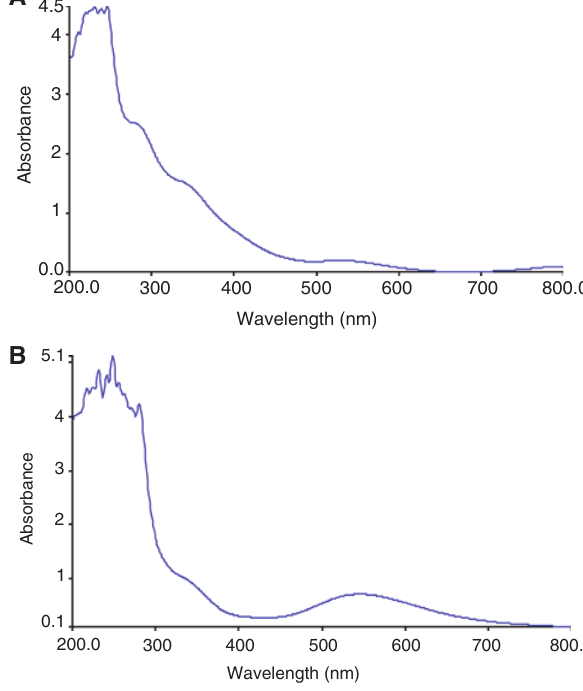
Figure 2: Electronic spectra for (A) tris(ethylenediamine)nickel(II) nitrate and (B) bis(ethylenediamine)copper(II)